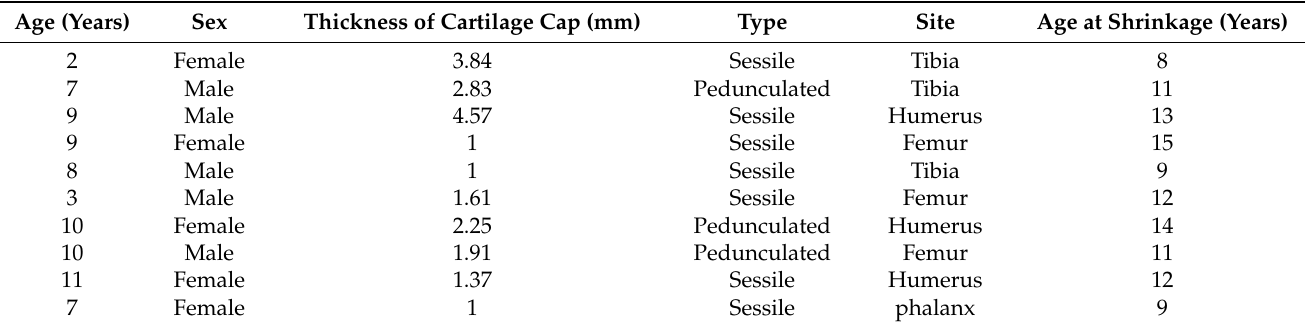
Table 2. The characteristics of the patients with spontaneous regression.